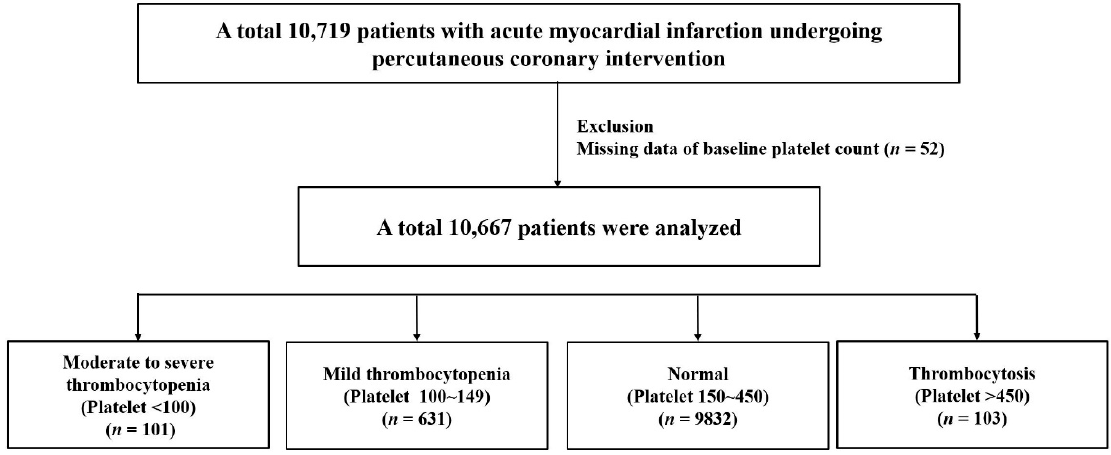
Figure 1. Study flow chart.